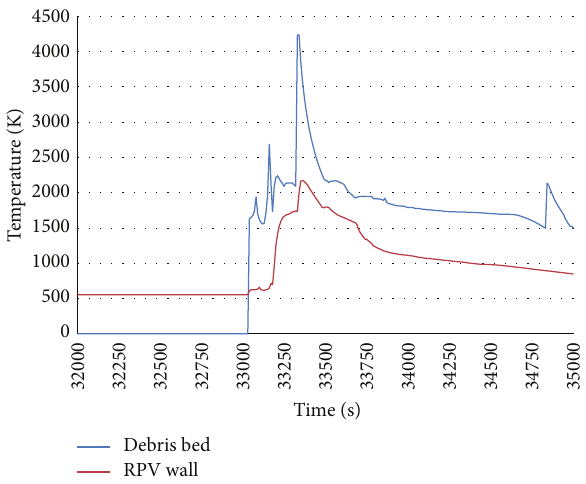
Figure 16: Pressure and void fraction evolution in primary contain- ment.